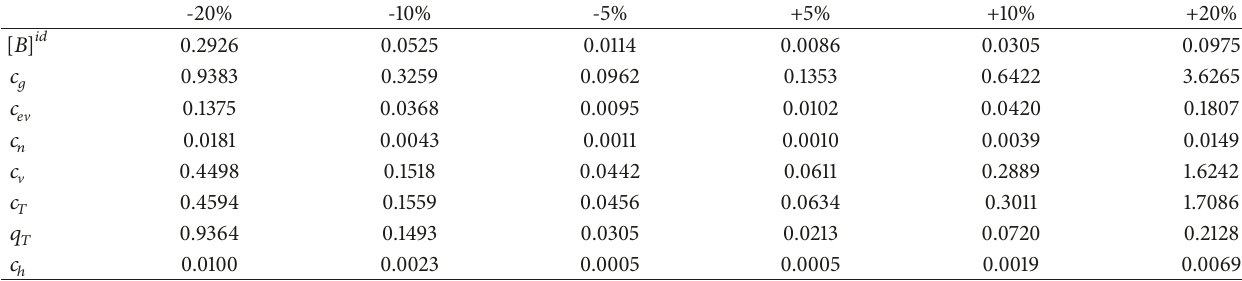
Table 6: Sensitivities ( 𝑆 ) of the model to the changes of parameters [𝐵] 𝑖𝑑 , 𝑐 𝑔 , 𝑐 𝑒 V , 𝑐 𝑛 , 𝑐 V , 𝑐 𝑇 , 𝑞 𝑇 , 𝑐 ℎ , 𝑞 𝐼 , and 𝑘 𝑉 in the case of therapy 1. One unit is 10 6 mm 3 .